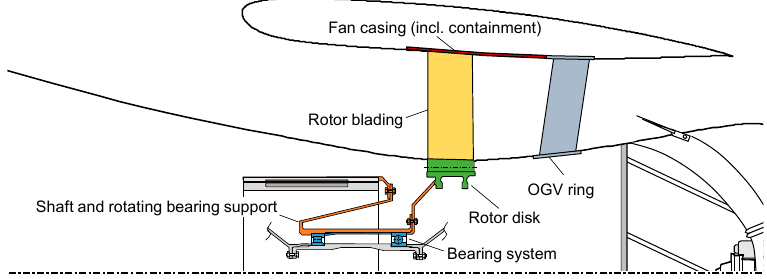
Figure 21. Visualization of control volume for FF module mass budget, individual component groups highlighted in color.